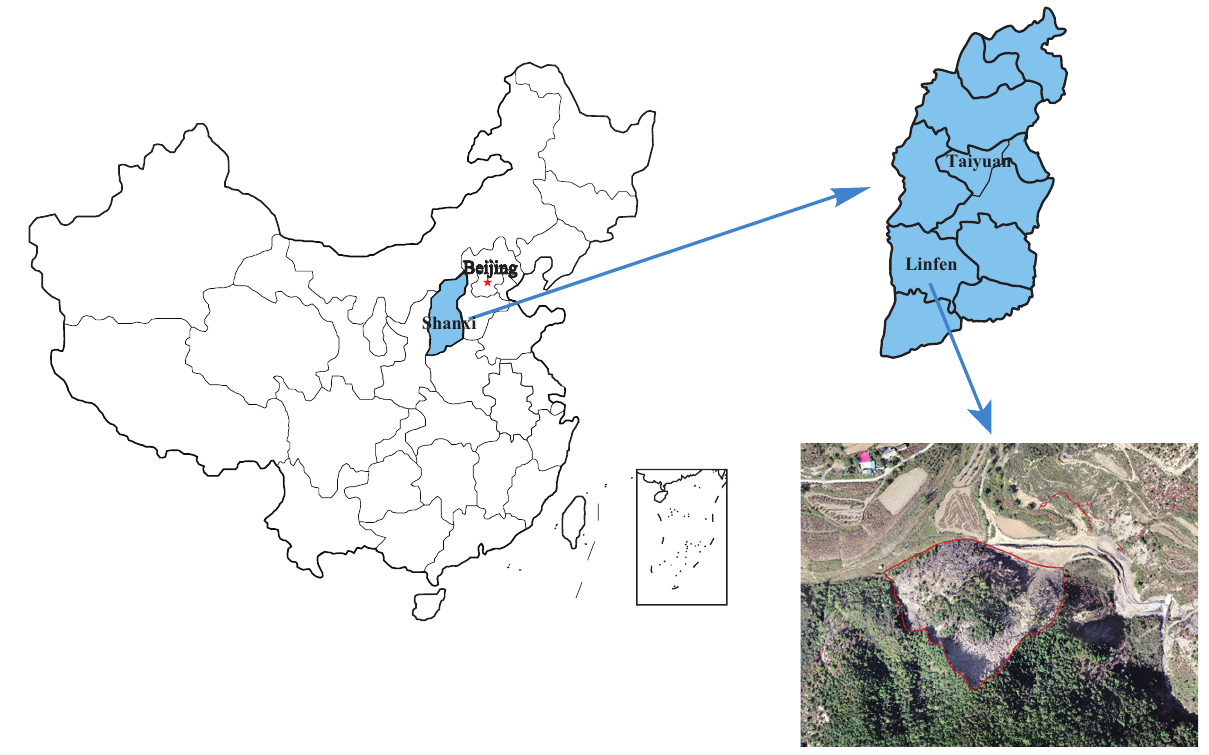
Figure 8. The location of the Songmugou landslide.